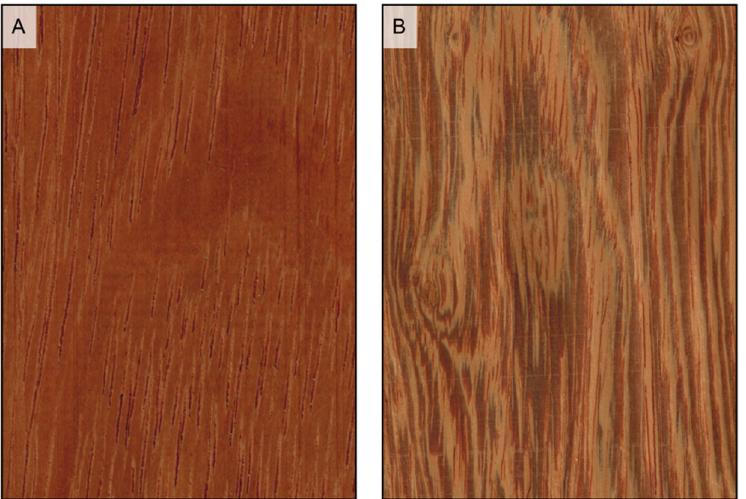
Figure 9. If prominent enough, axial parenchyma appears on longitudinal surfaces as a light-colored band along the vessels’ grooves when paratracheal (( A ) Afzelia bipindensis ), and as seemingly growth rings when apotracheal in tangential bands (( B ) Amphimas pterocarpoides ).